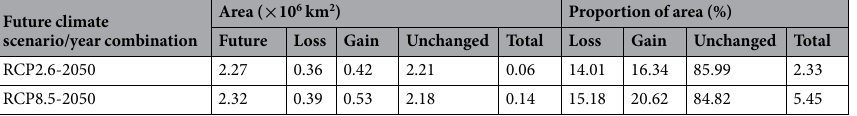
(regions with a probability threshold > 0.166): Shaanxi, Hubei, Henan, Sichuan, Hebei, Shandong, Shanxi, Anhui, Hunan, Liaoning, Jiangsu, Gansu, Chongqing, Guizhou, Zhejiang, Jiangxi, Inner Mongolia, Yunnan, Beijing, Ningxia, Tianjin, Shanghai, Jilin, Guangxi, Guangdong, Xizang, Fujian, and Heilongjiang Provinces (Tables 2 and S4). Among the provinces, Henan, Shandong, and Hebei Provinces had the most highly, moderate, and mar- ginally suitable habitat areas for P . ostii , respectively. The current total suitable area in China for this species was predicted to encompass ca. 20.31 × 10 5 km 2 .